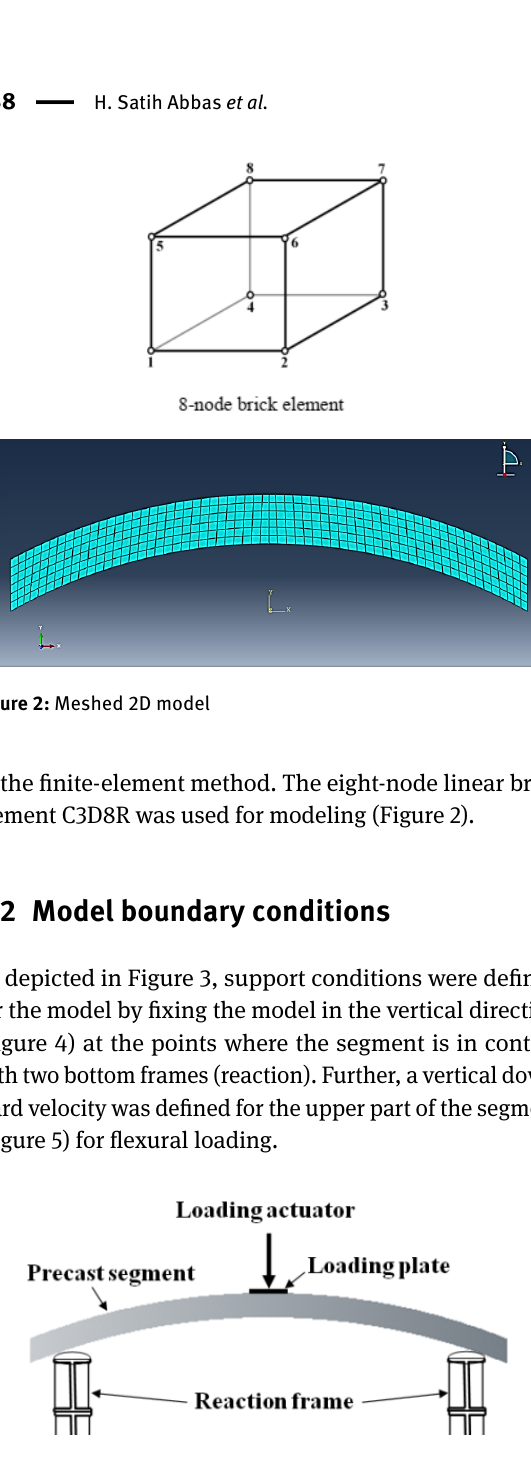
Figure 3: Experimental boundary conditions in the lower part of the segment Abbas [37]